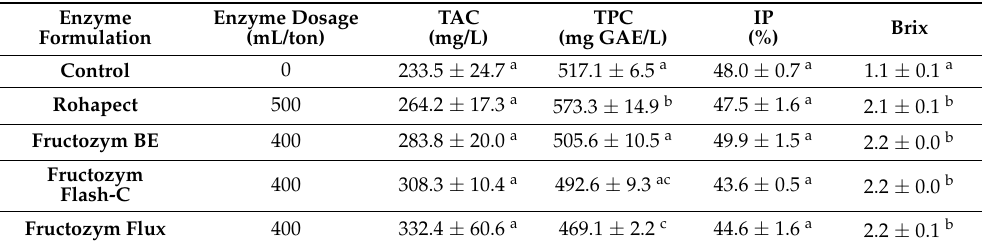
Table 1. Total anthocyanin content (TAC), total phenol content (TPC), inhibition percentage of the DPPH radical (IP), and Brix degrees for the chokeberry